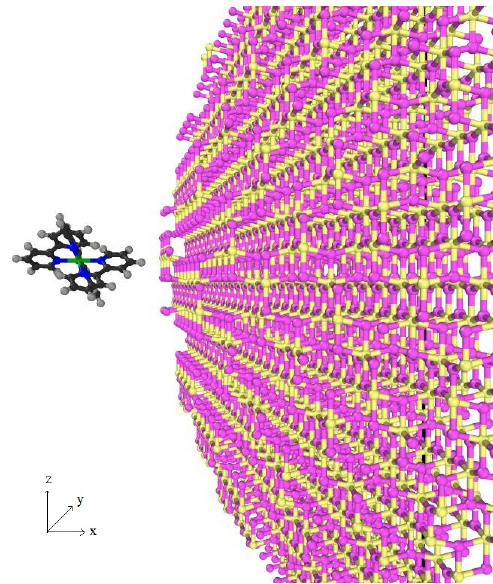
Figure A2. Interaction between the dye molecule and TiO 2 where titanium (Ti) is yellow and oxygen (O) is